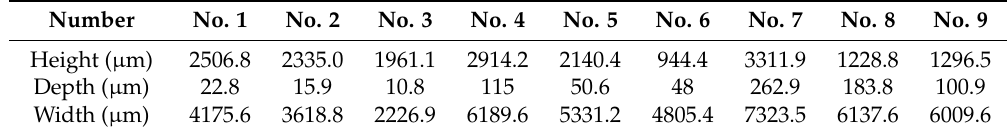
Figure 4. Macro-appearance of the cross section. Table 3. Size of all nine groups of samples.